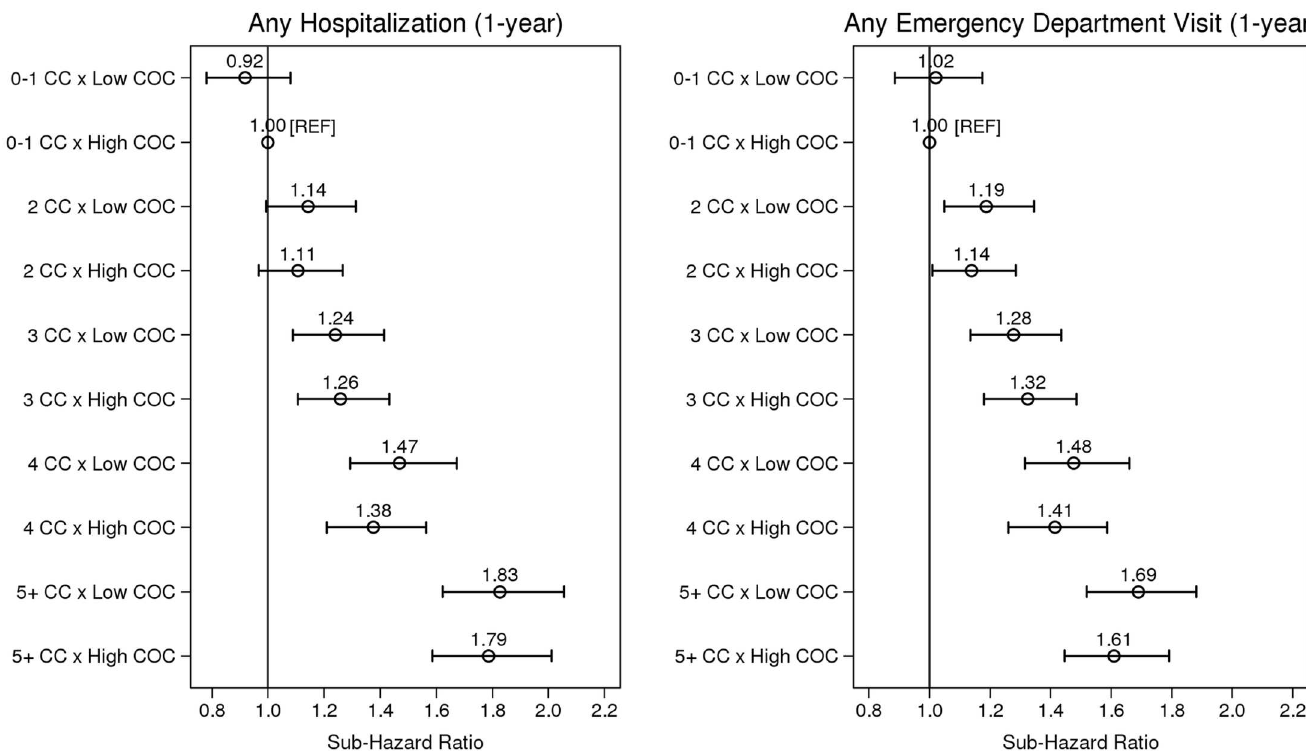
Fig 1. The association between level of multimorbidity and 1-y risk of acute hospitalization and emergency department visit as modified by continuity of care. Sub-hazardratios account for the competingrisks of death and long-termcare admission.Estimates adjusted for age, sex, income, marital status, rurality, prior hospitalizations and ED visits, Minimum Data Set Health Status Index, and Changesin Health, End-stage diseaseand Symptoms and Signs scale. CC, chronic condition; COC, continuityof physiciancare.